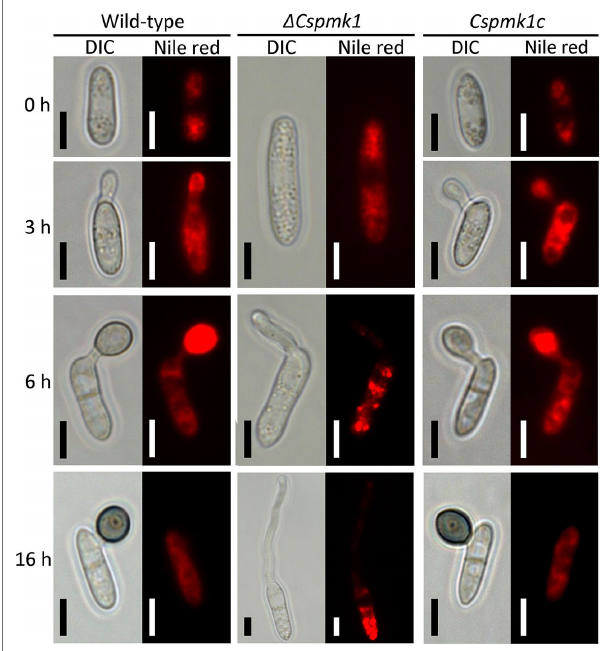
(5 × 10 4 ml − 1 ) were placed on the hydrophobic surface of coverslips and incubated at 25 ° C. Nile red was used to stain lipid droplets during conidial germination and appressorium formation. Scale bar, 5 μ